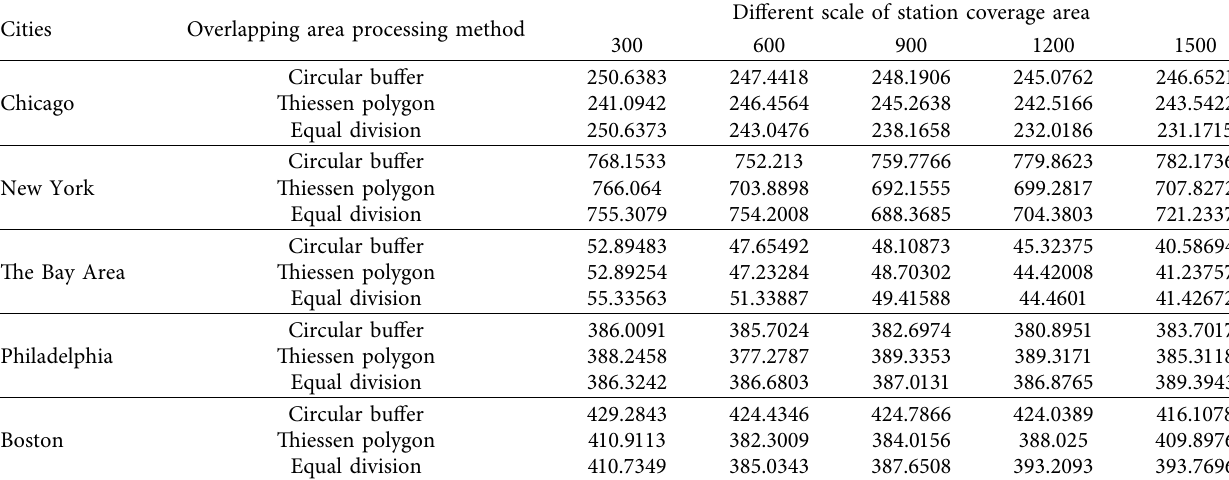
Table 12: Table of the AIC of log-linear regression model in five